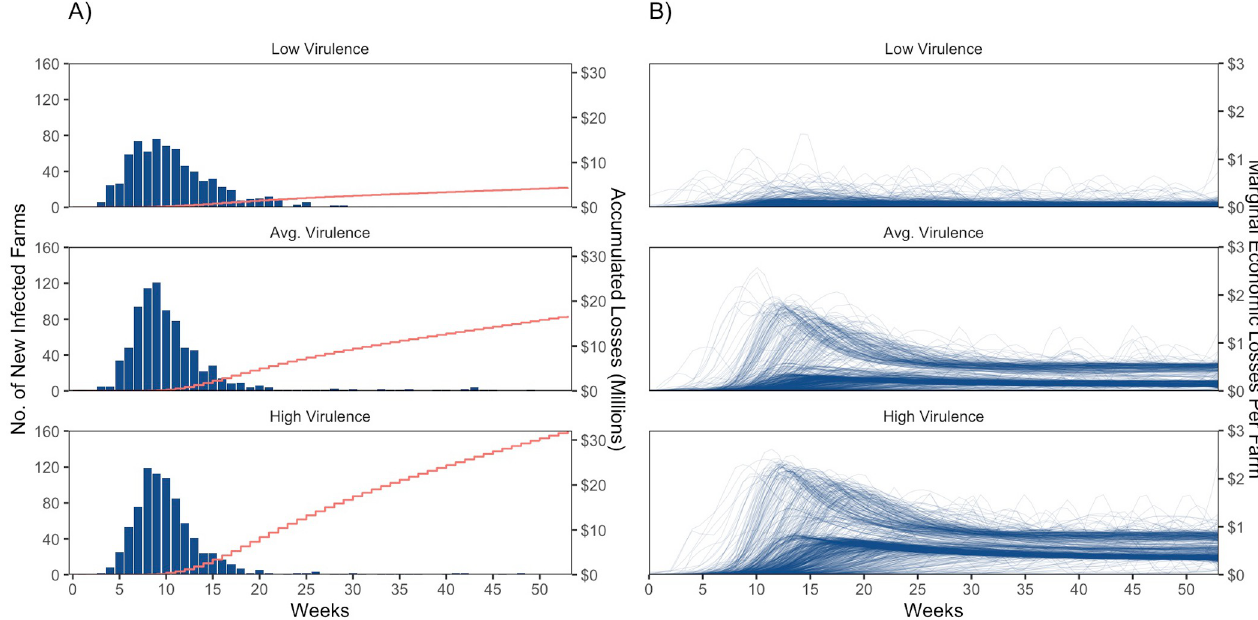
Fig 2. Baseline scenario of PRRS spread under three strains. (A) Number of New Positive Farms (Bars) and Cumulative Economic Losses (Red Lines). (B) Marginal Economic Losses for Each Infected Farm over Time.